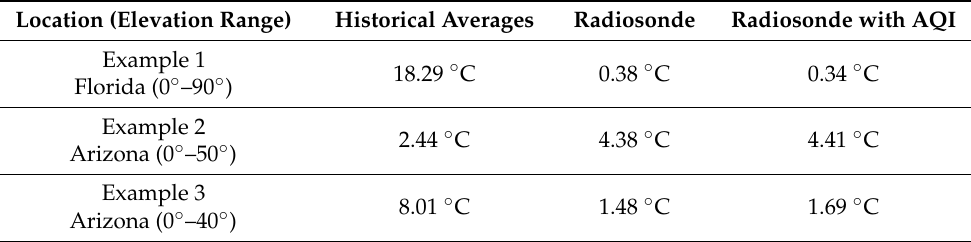
Table 3. The average temperature difference between measured data and atmosphere profiles over elevation ranges for LWIR.